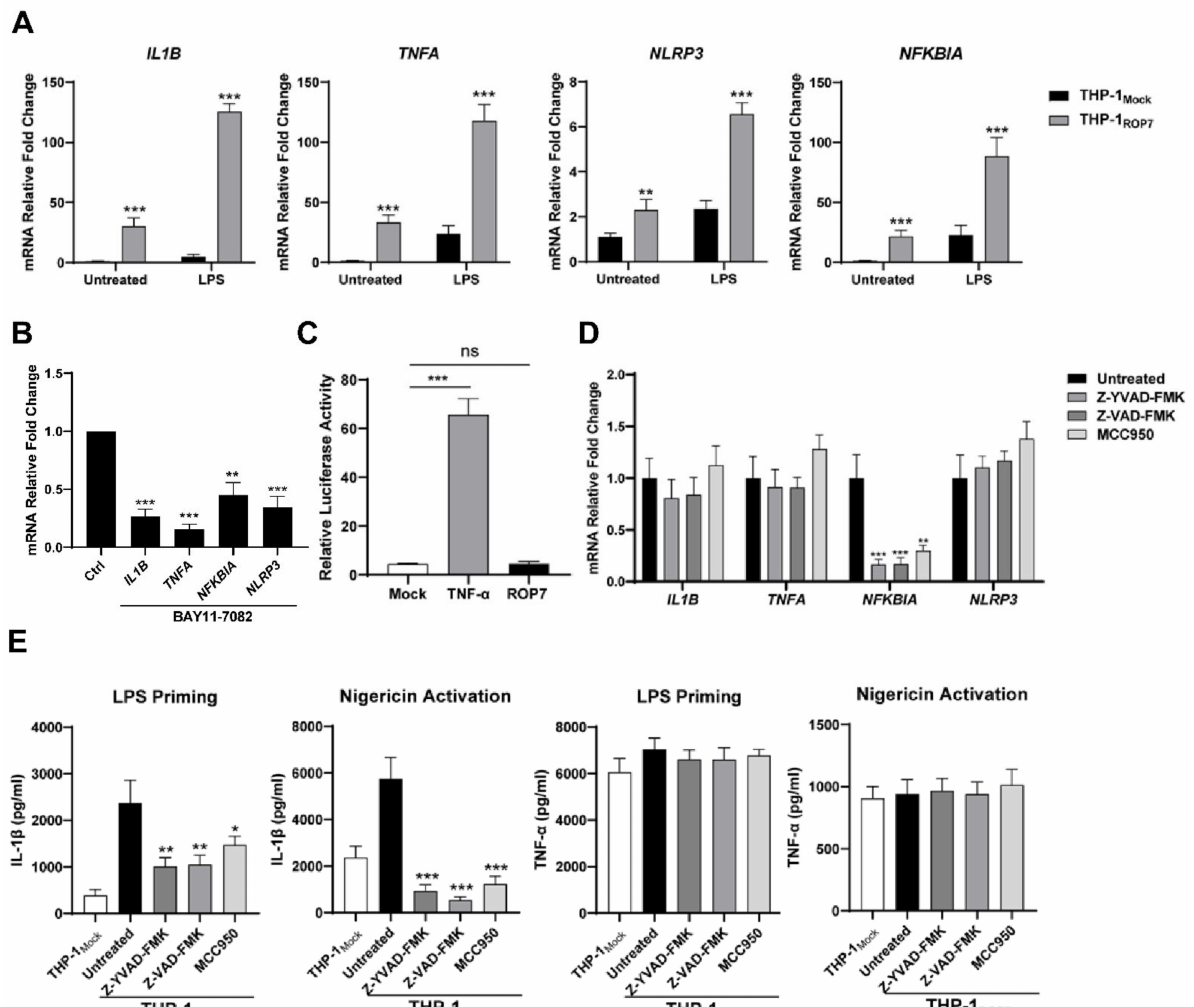
Figure 4. The NF- κ B signaling pathway was activated in THP-1 ROP7 , but its activation was not directly derived from ROP7. THP-1 Mock and THP-1 ROP7 were induced by 1- µ g/mL doxycycline for 48 h and differentiated under 100-nM PMA for another 48 h ( A ) or with 10- µ M BAY11-7082 in THP-1 ROP7 . ( B ) Total RNA was extracted, and the mRNA relative fold changes were determined via RT-qPCR. ( C ) The 293T cells were co-transfected with a dual-luciferase reporter plasmid (ranilla: firefly 1:10) for NF- κ B. pcDNA3-HA-ROP7 or empty plasmids (mock). At 48 h post-transfection, luciferase activity was examined, and the values were normalized according to the ratio of firefly luciferase activity and ranilla luciferase activity. In total, 20-ng/mL TNF- α was used as a positive control. ( D ) THP-1 ROP7 cells were induced by 1- µ g/mL doxycycline for 48 h and differentiated under 100-nM PMA for another 48 h along with 10- µ M Z-YVAD-FMK, Z-VAD-FMK, or MCC950. Total RNA was extracted, and the mRNA relative fold changes were determined via RT-qPCR. ( E ) THP-1 Mock and THP-1 ROP7 were induced by 1- µ g/mL doxycycline for 48 h and differentiated under 100-nM PMA for another 48 h. Then, 100-ng/mL LPS for 4 h and 10- µ M nigericin for 1 h subsequently were used to activate NLRP3 inflammasomes. In total, 10- µ M Z-YVAD-FMK, Z-VAD-FMK, or MCC950 was added with LPS or nigericin. The IL-1 β and TNF- α supernatant concentrations were detected by ELISA. Data are expressed as mean ± SEM values. ns: non-significant, * p < 0.05, ** p < 0.01, *** p < 0.001, as compared with untreated